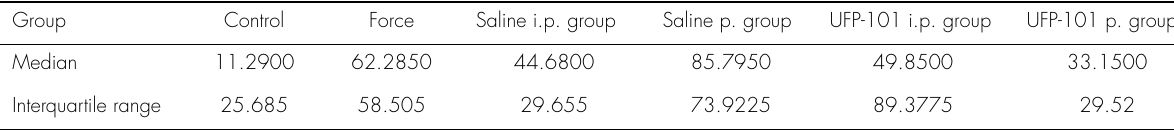
Table I. Mouth wiping (pain level) following experimental tooth movement in